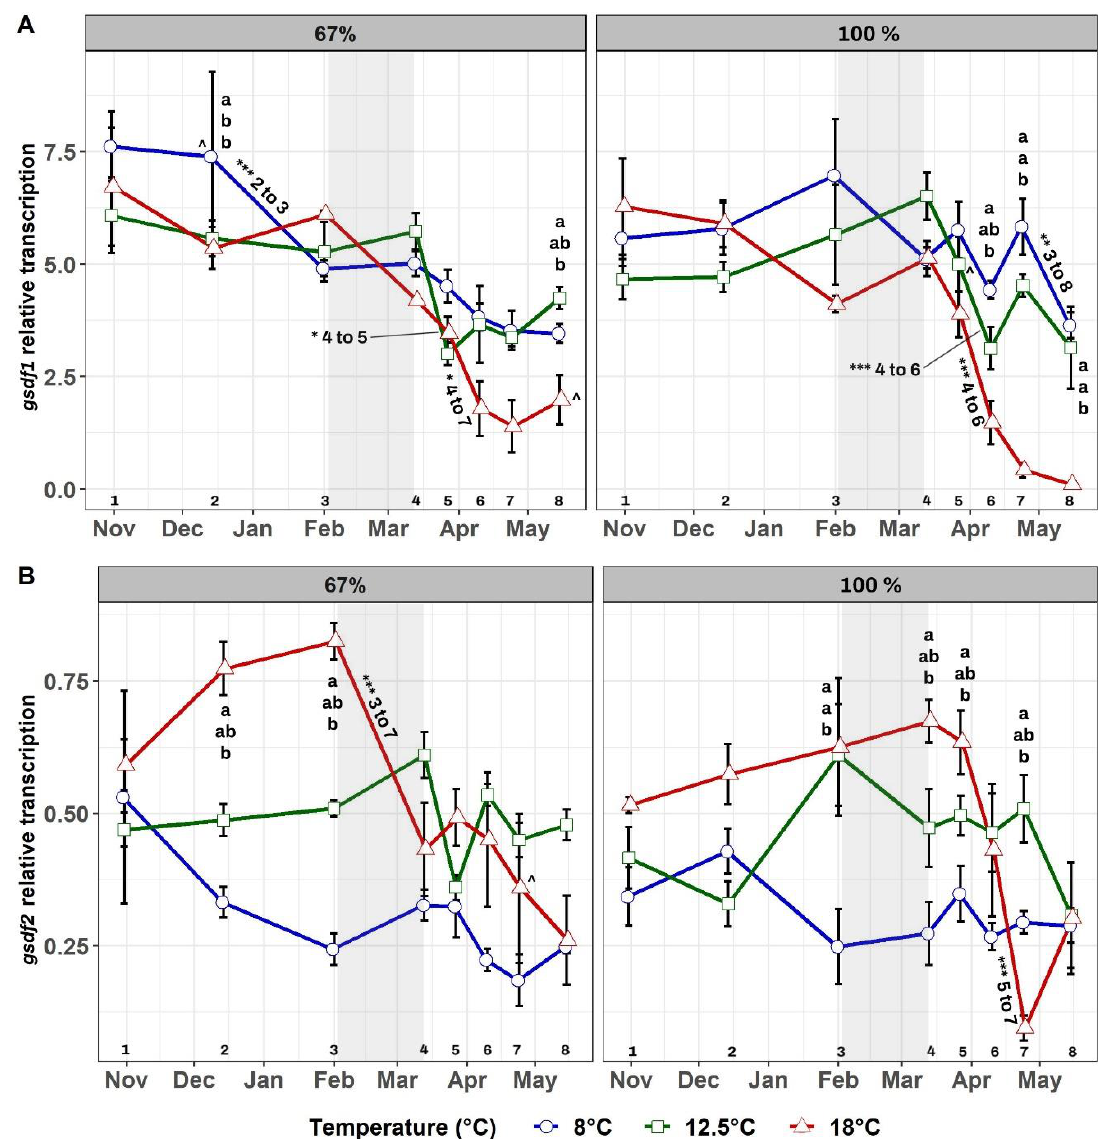
Figure 5. Mean testis gsdf1 ( A ) and gsdf2 ( B ) transcription over time in the six experimental groups. Feeding regimes are displayed separately, with the 67% groups shown on the left and the 100% ration groups on the right. The grey-shaded area shows the duration of the LD12:12 winter signal. Letters “a” and “b” indicate significant differences ( p < 0.05) between groups within a feeding regime for a given time. Signs “^” indicate significant differences ( p < 0.05) between groups reared at the same temperature but at different feeding regimes at a given time, and they are located next to the largest value of the pair. Numbers from 1 to 8 at the bottom of the graphs represent the sampling number and aid with an explanation of significant differences over time within each group. These are displayed with asterisks as follows: (*) p -value < 0.05, (**) p -value < 0.01, and (***) p -value < 0.001. Asterisks are located next to the corresponding line and are followed by the sampling numbers between which such significant difference